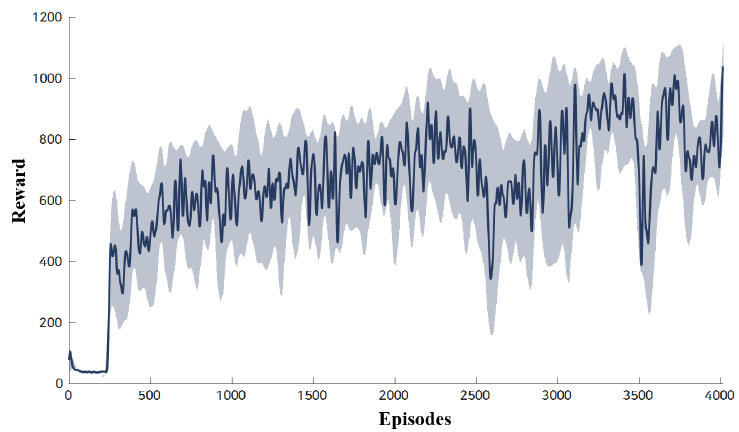
Figure 9. Learning curve—scenario